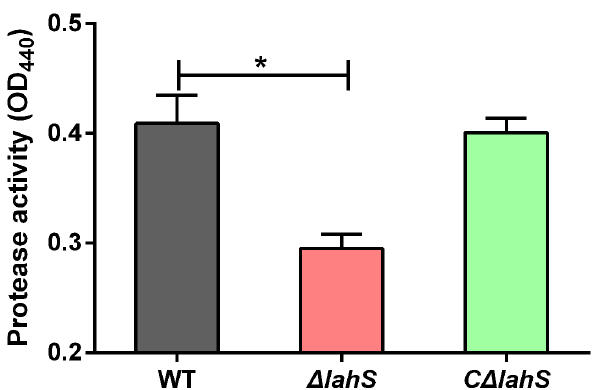
Figure 8 . Protease activity of the wild-type and lahS mutant strains. The protease activity was detected using azocasein as a protease substrate and was measured at OD 440 . Data are presented as the means ± SEM of three independent experiments. * p < 0.05.